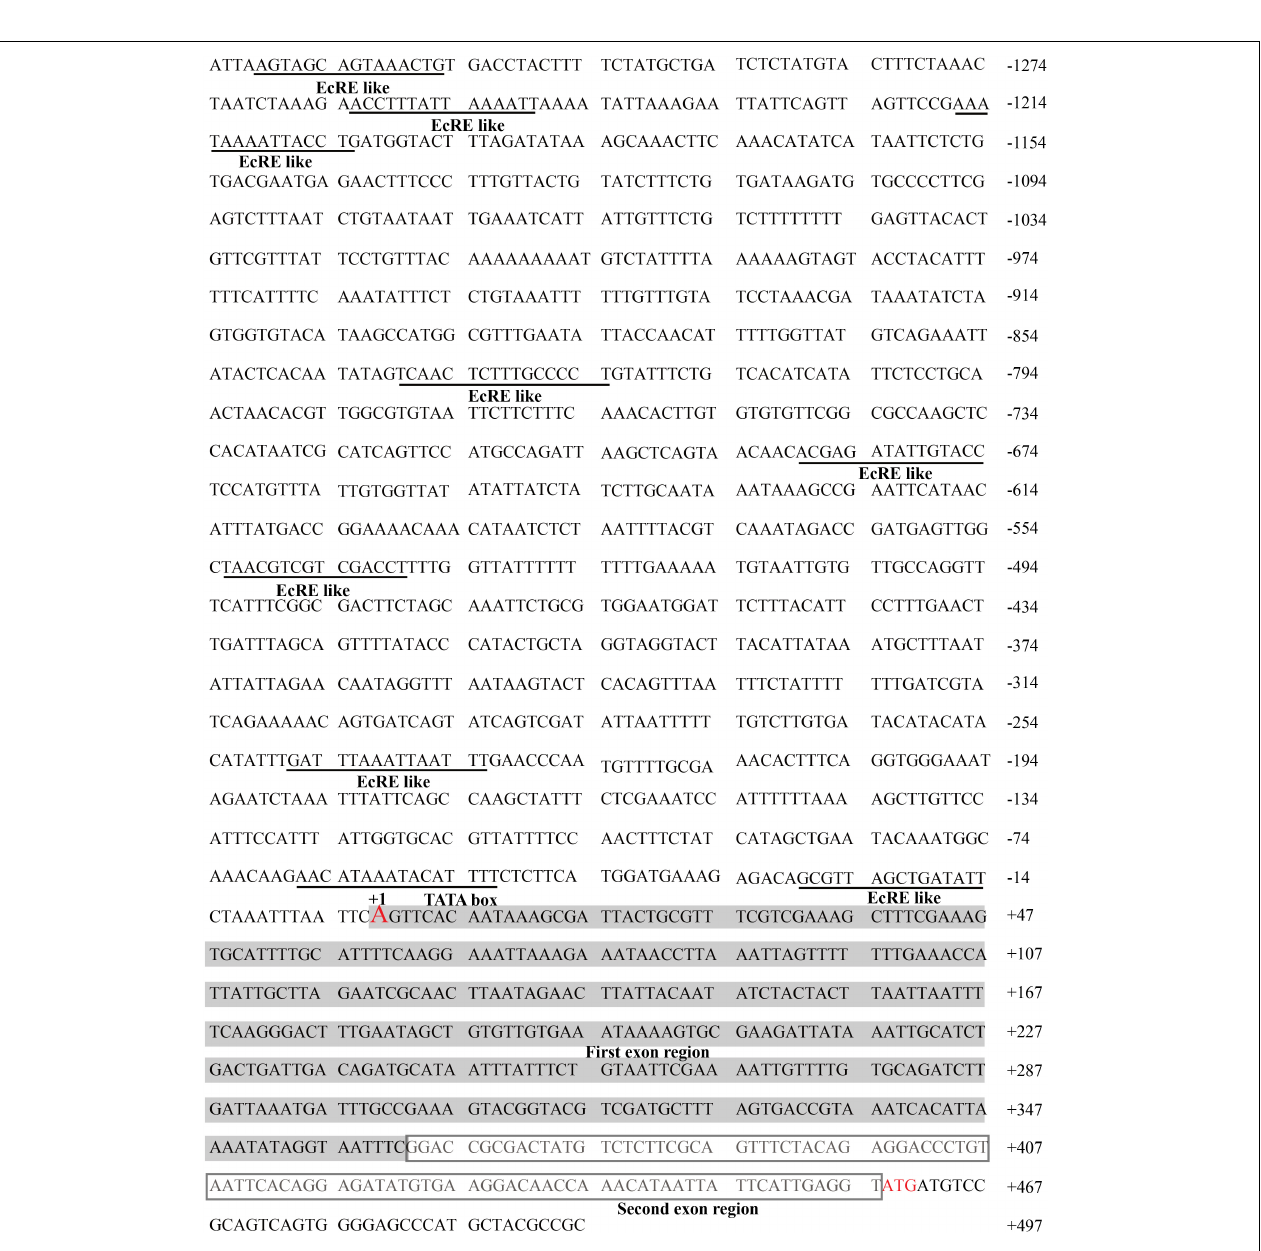
FIGURE 1 | Sequence analysis of the 5 (cid:48) -flanking region of Bombyx mori ERR ( BmERR ). The nucleotides are numbered relative to the translation start site indicated by + 1, with upstream sequences preceded by “–.” The transcription start site (TSS) and translation start site are indicated in red. The putative transcription factor (TF)-binding sites are labeled. The light gray area represents the first exon sequence and the dark box represents the second exon sequence. Eight putative EcRE motif are predicted on the BmERR